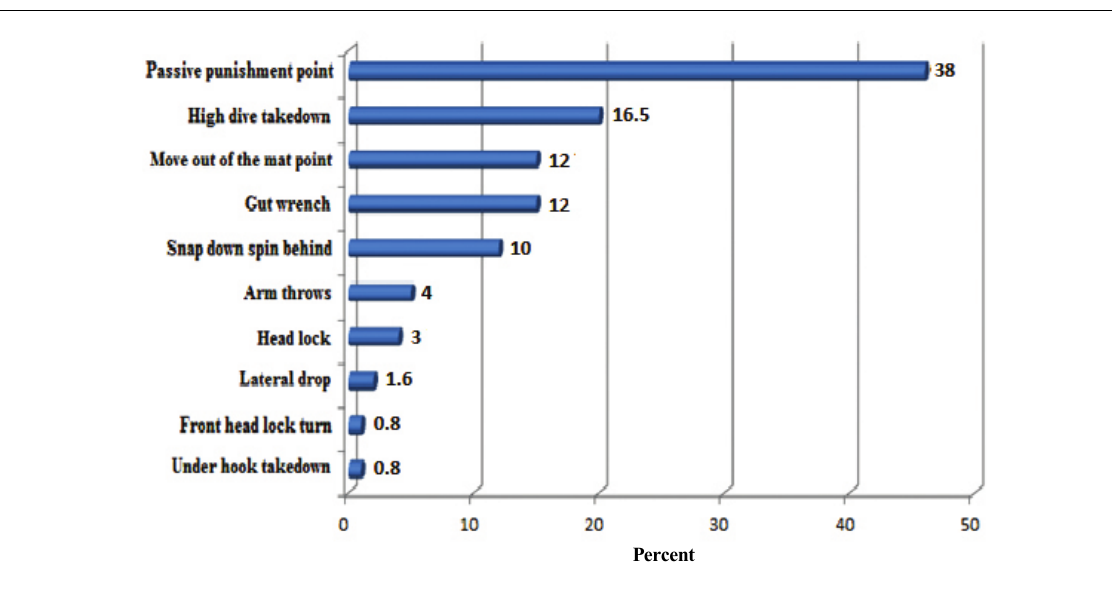
Figure 3. The percentage distribution of successful techniques made by middleweight wrestlers Figure 4. The percentage distribution of middleweight wrestlers’ winning types Figure 5. The percentage distribution of successful technique made by heavyweight wrestlers’